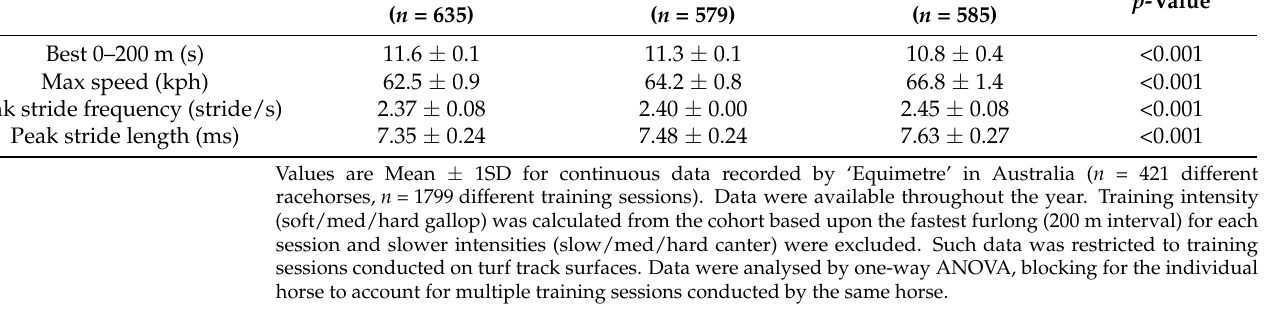
Table 2. Descriptive characteristics of the training dataset. Soft Gallop